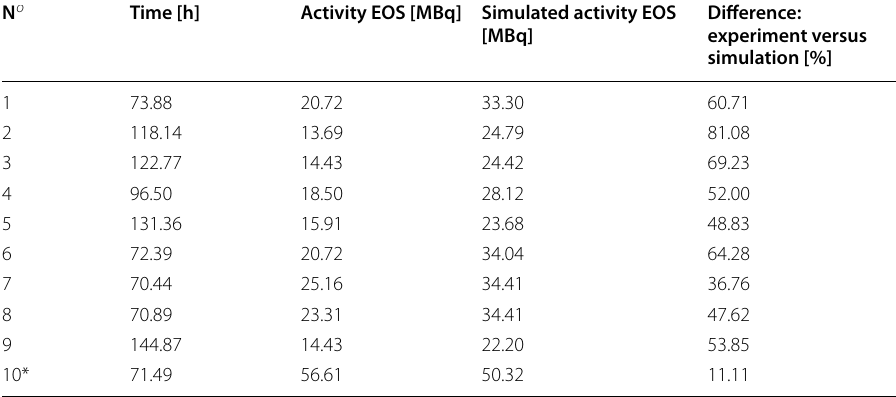
The irradiation parameters: the proton beams of 10 μA (N o : 1-9) and of 15 μA (N o : 10 denoted with *), irradiation time of 1.5 h, the thickness of the Havar foil: 0.2 mm. The results are obtained at the end of separation (EOS) and Time [h] is the time difference between the end of bombardment and the end of separation